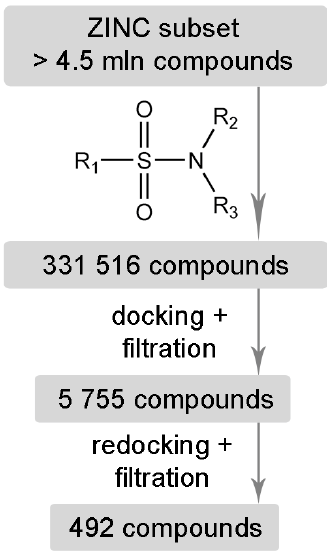
Arg371 guanidinium group.